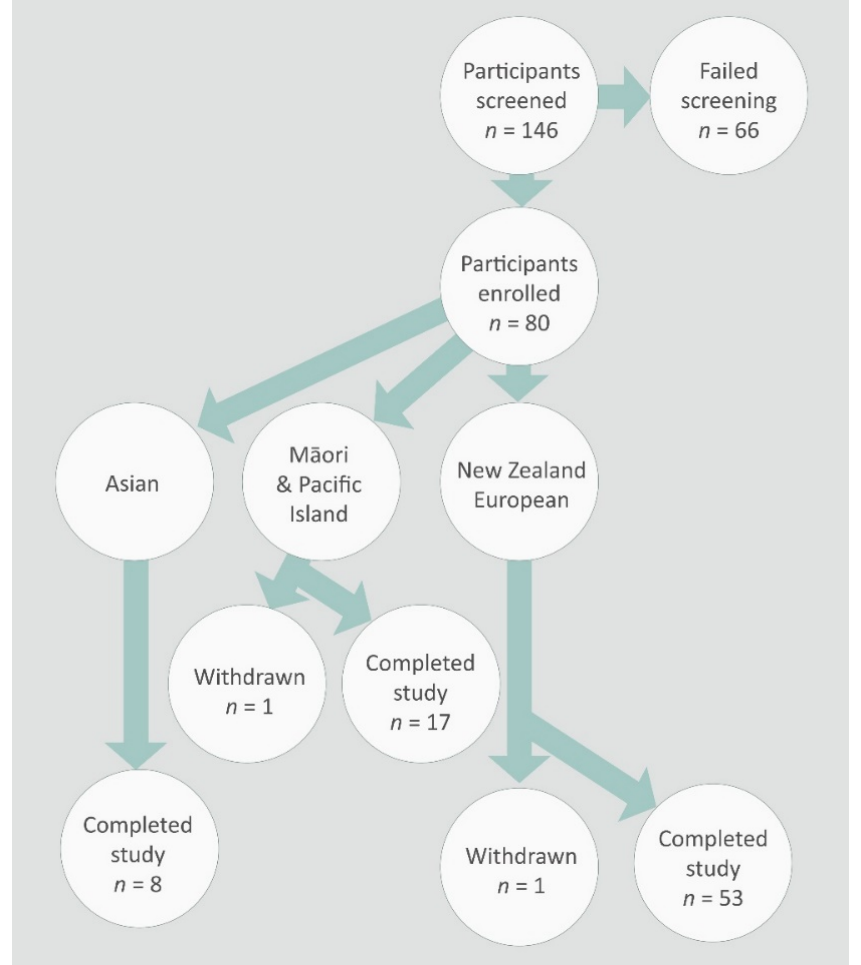
Figure 1. Flow chart of the participant recruitment into the study.